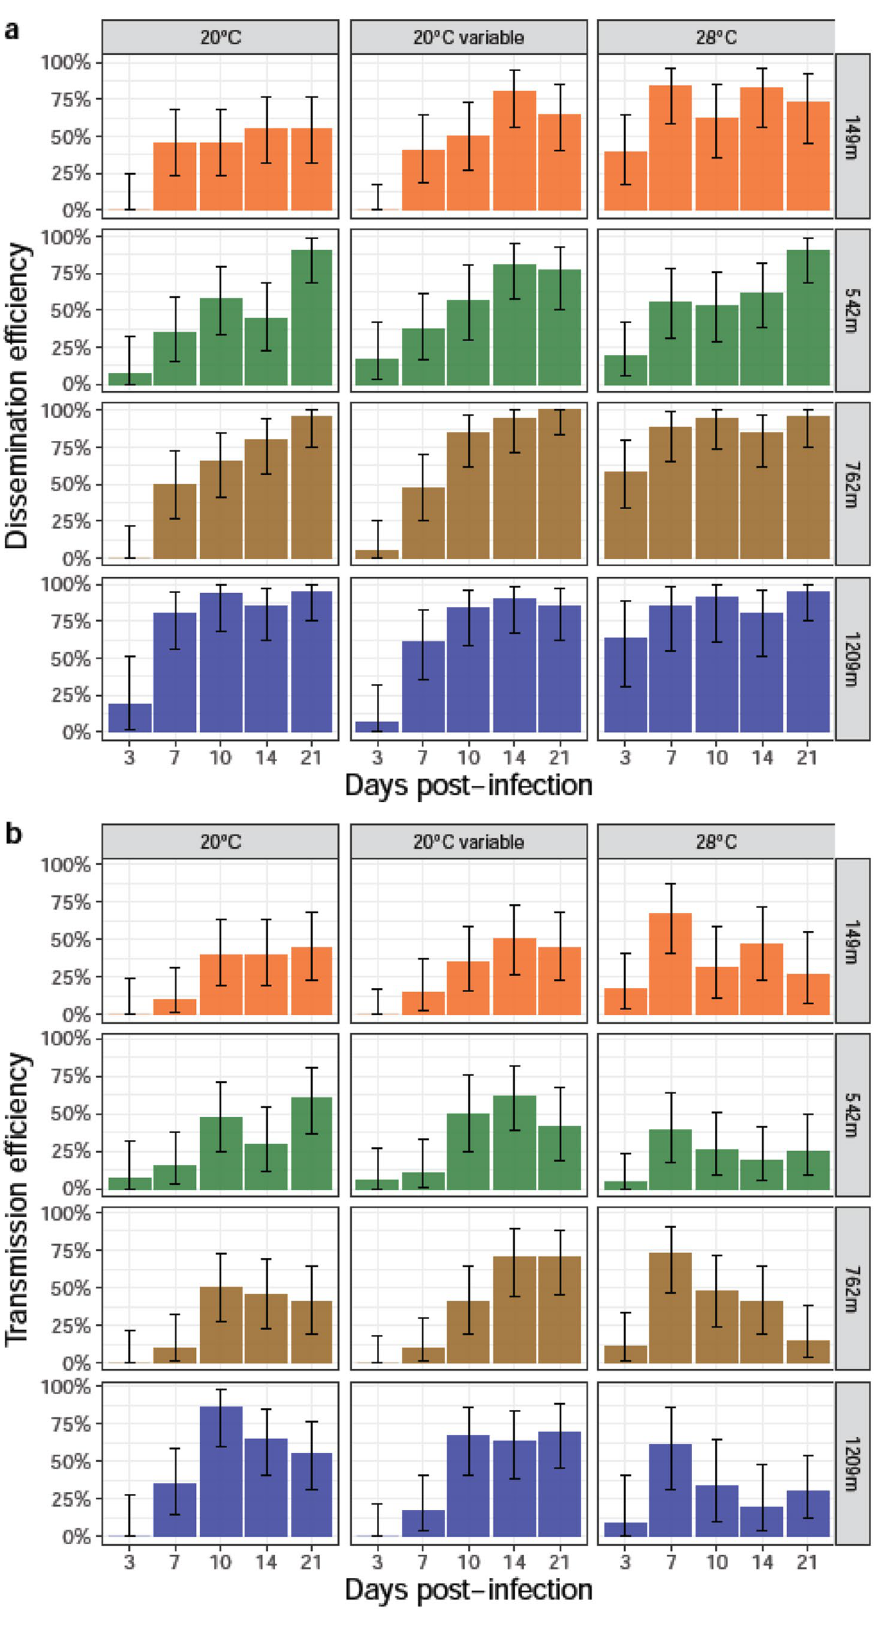
Figure 2. Dissemination and transmission efficiencies of Ae. albopictus populations infected with CHIKV examined at different days (3, 7, 10, 14, and 21) after incubation at different temperatures (20 °C, 20 °C variable, 28 °C). After infection, mosquito heads and saliva were titrated. ( a ) Dissemination efficiency corresponds to the proportion of mosquitoes with infected heads. ( b ) Transmission efficiency refers to the proportion of mosquitoes with infectious saliva. Error bars show the exact Binomial confidence interval